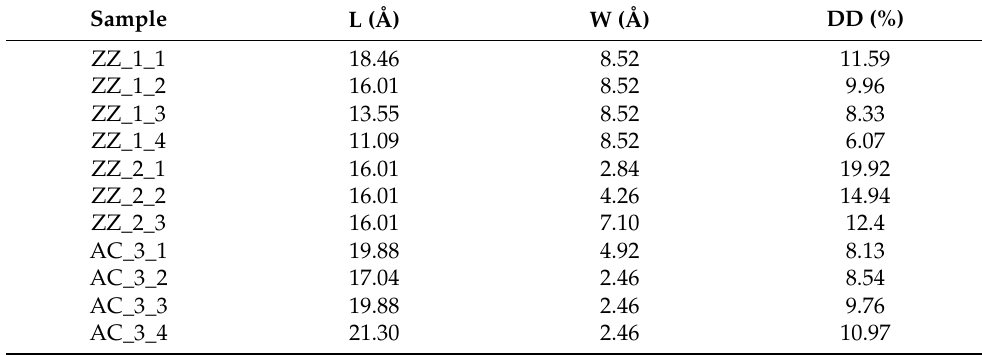
Figure 1. ( a ) Creating a zigzag-incised graphene kirigami (GK). The carbon atoms in the dotted line were deleted and all bonds were capped using hydrogen. The monolayer GK with ( b ) zigzag incisions and ( c ) armchair incisions [29]. Table 1. Design parameters of the monolayer GK sheets.